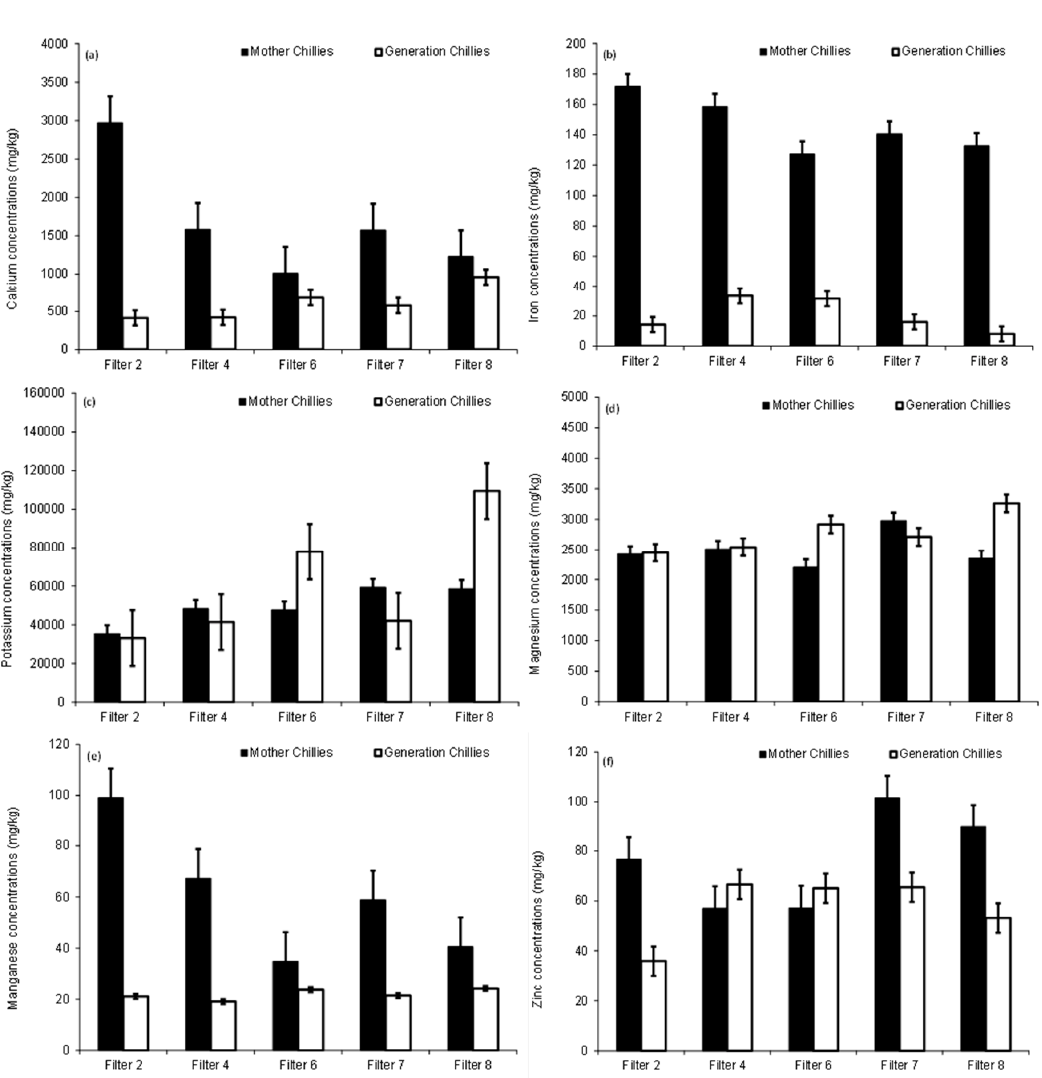
Figure 7. Chilli generations: ( a ) calcium, ( b ) iron, ( c ) potassium, ( d ) magnesium, ( e ) manganese, and ( f ) zinc.